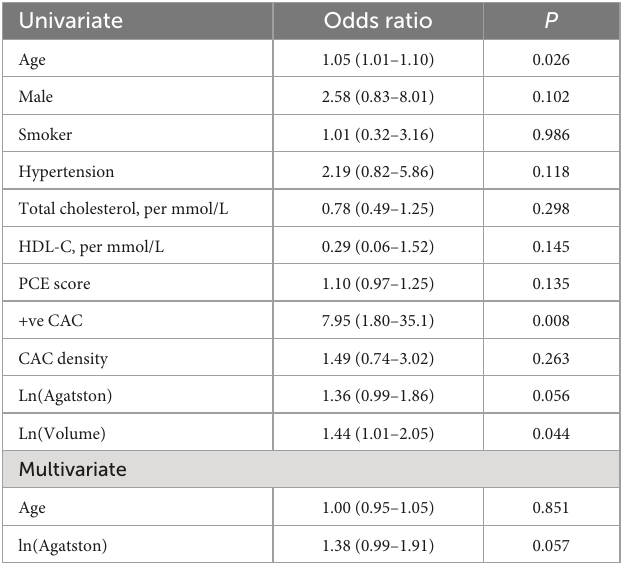
TABLE 2 Univariate and multivariate analysis for CAC scores and various risk factors for